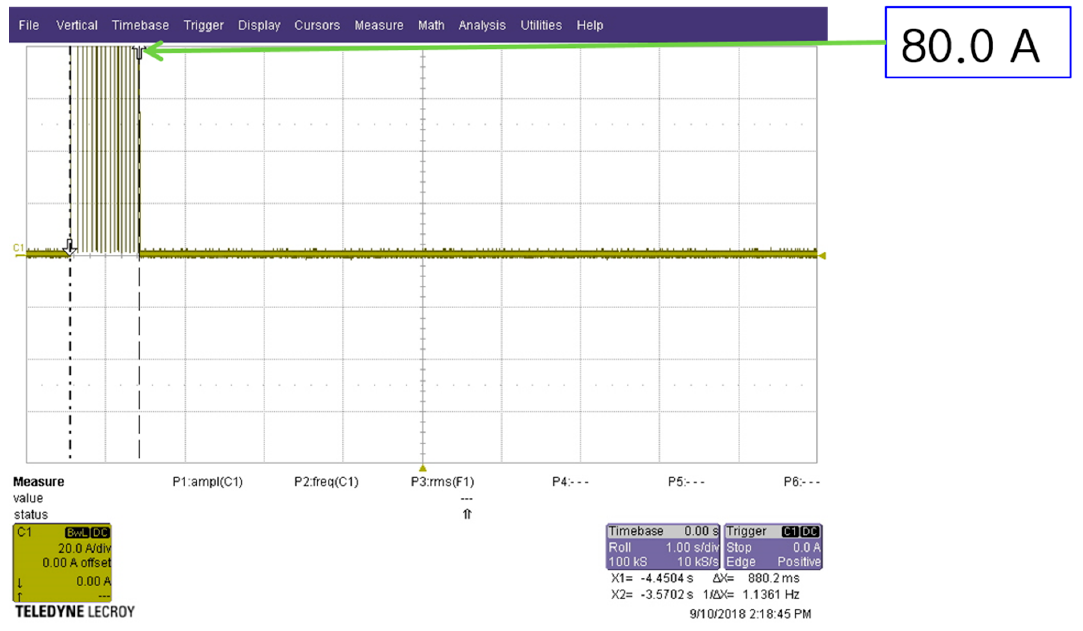
Figure 7. Test results of short-circuit protection.